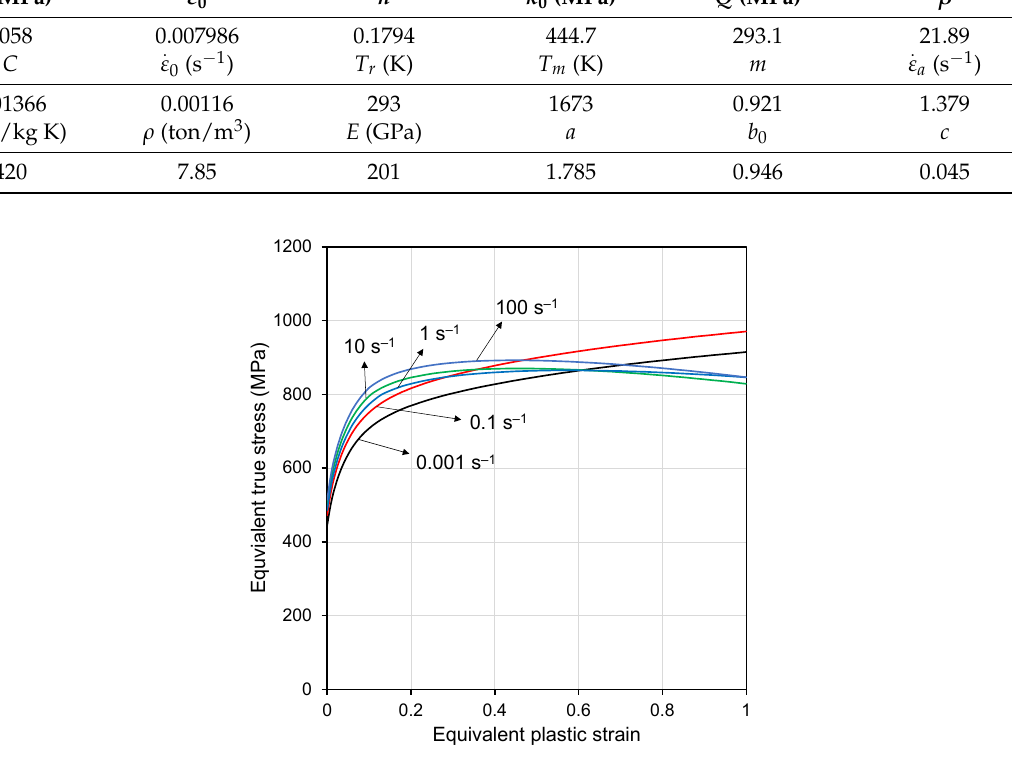
Figure 7. Flow stress curves at different strain rates.